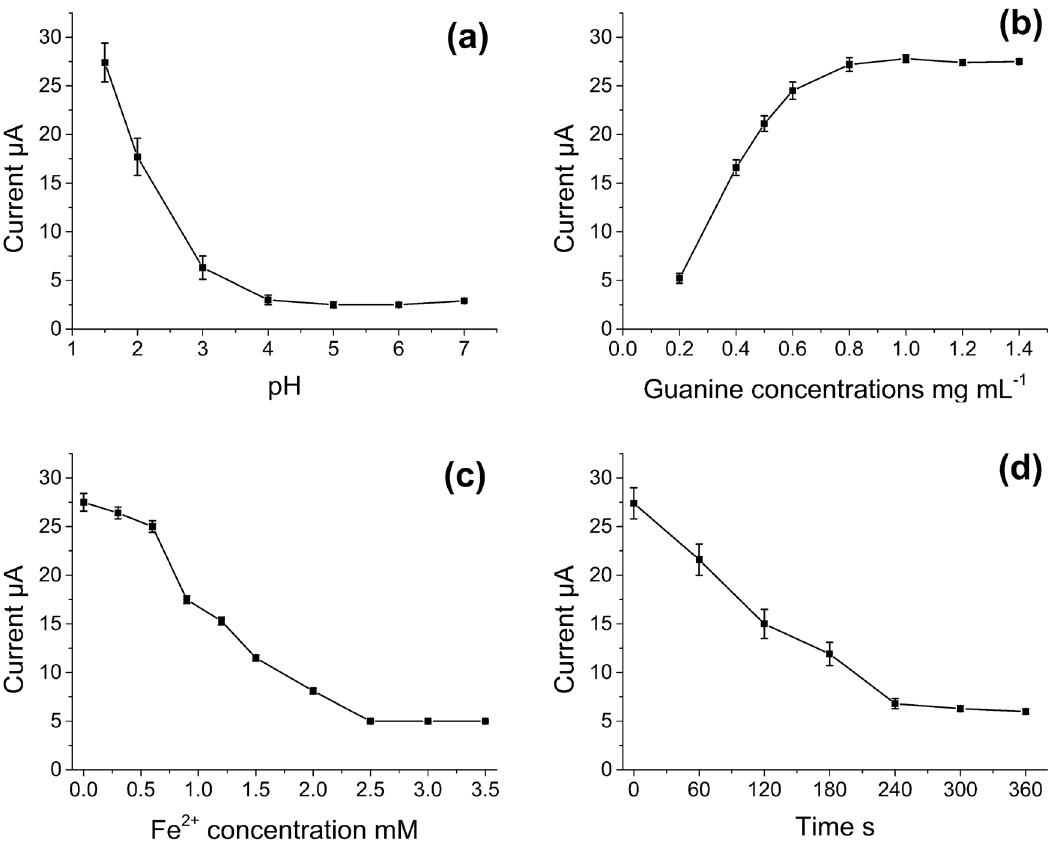
Figure 3: E ff ects of ( a ) pH, ( b ) guanine concentration, ( c ) Fe 2 + concentration, and ( d ) incubation time on the oxidant peak currents of G/PTH/NG/GCE.